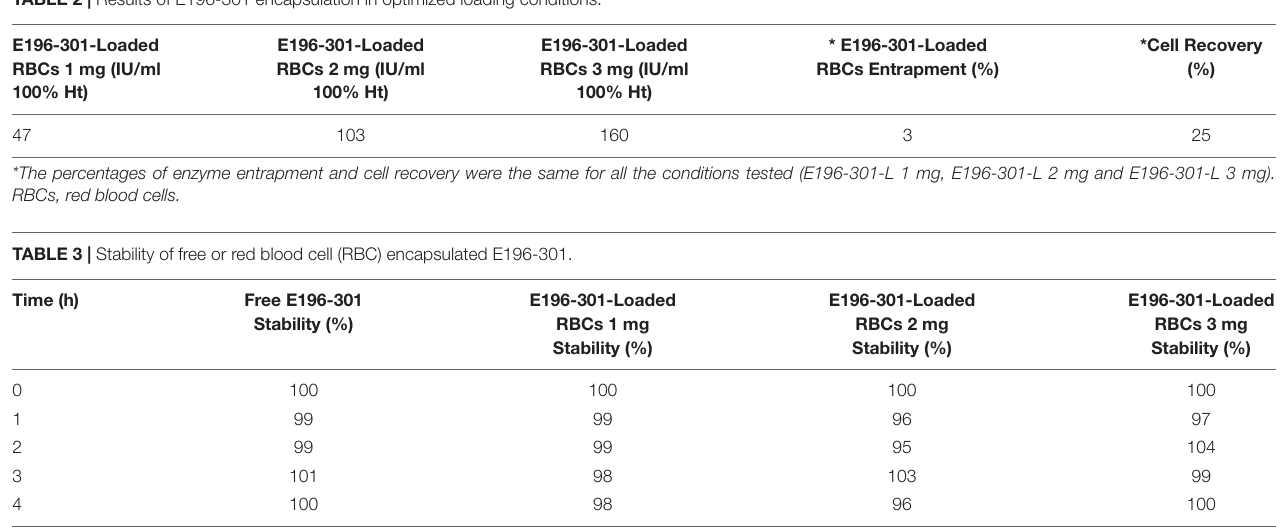
TABLE 2 | Results of E196-301 encapsulation in optimized loading conditions.